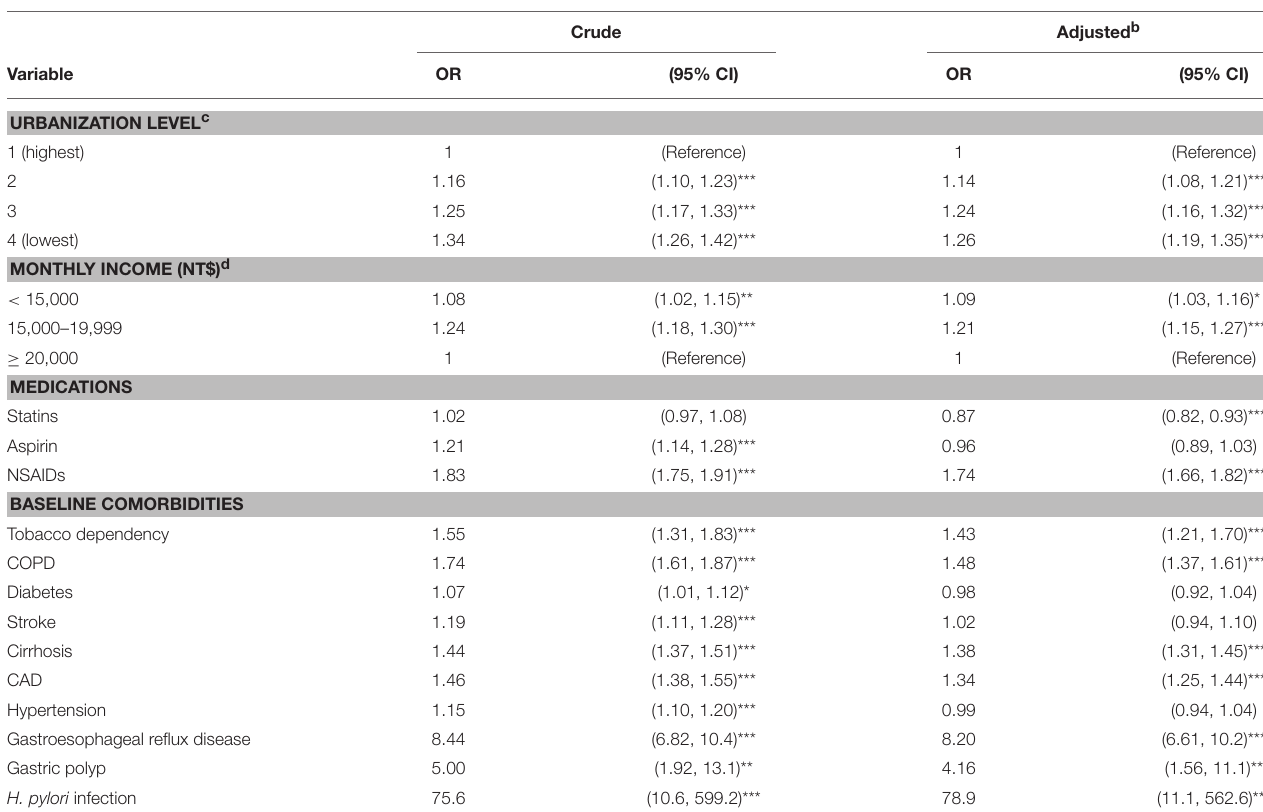
TABLE 2 | Odds ratios and 95% confidence intervals of PUD associated with statin use and covariates a